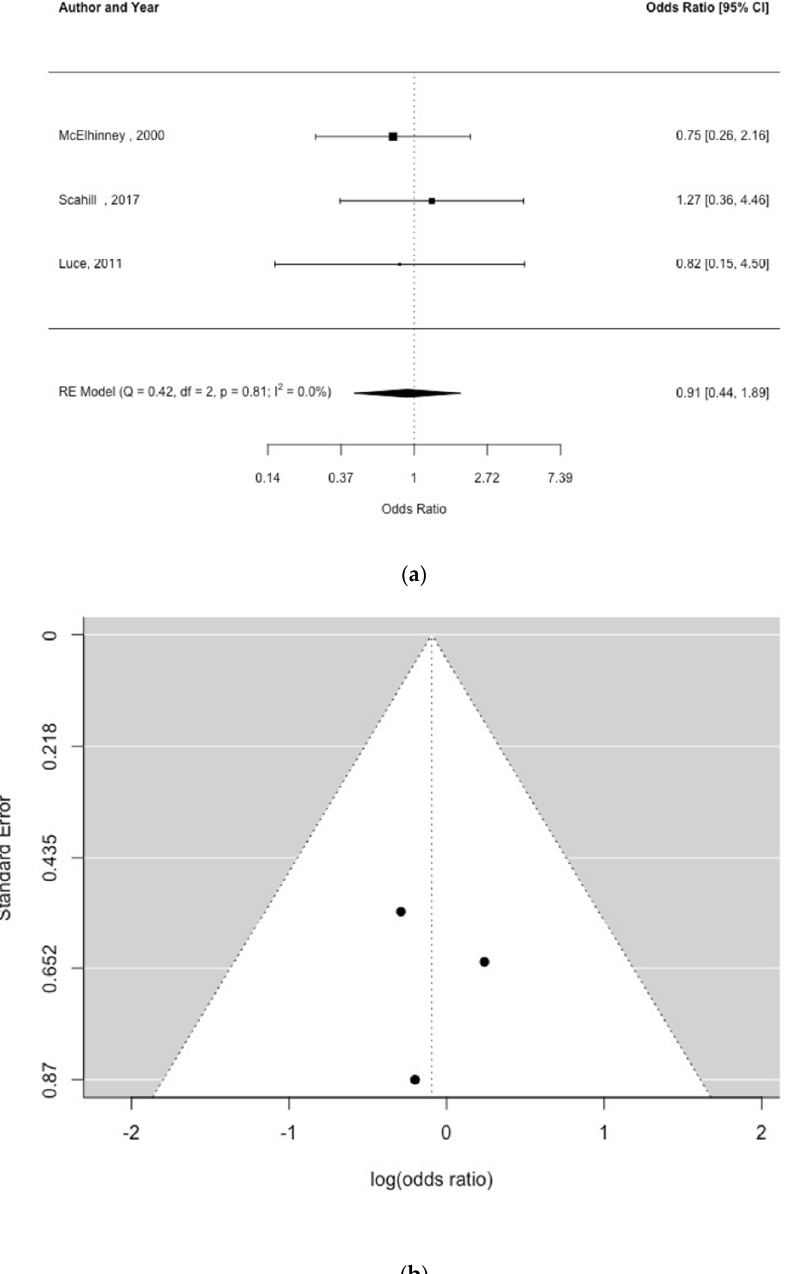
Figure 4. Forest plot ( a ) and funnel plot ( b ) of study effect estimates for umbilical catheter and NEC [shown as odds ratios and log (odds ratios), respectively] [5,23,24]. Egger’s test did not indicate funnel plot asymmetry [ p = 0.914].